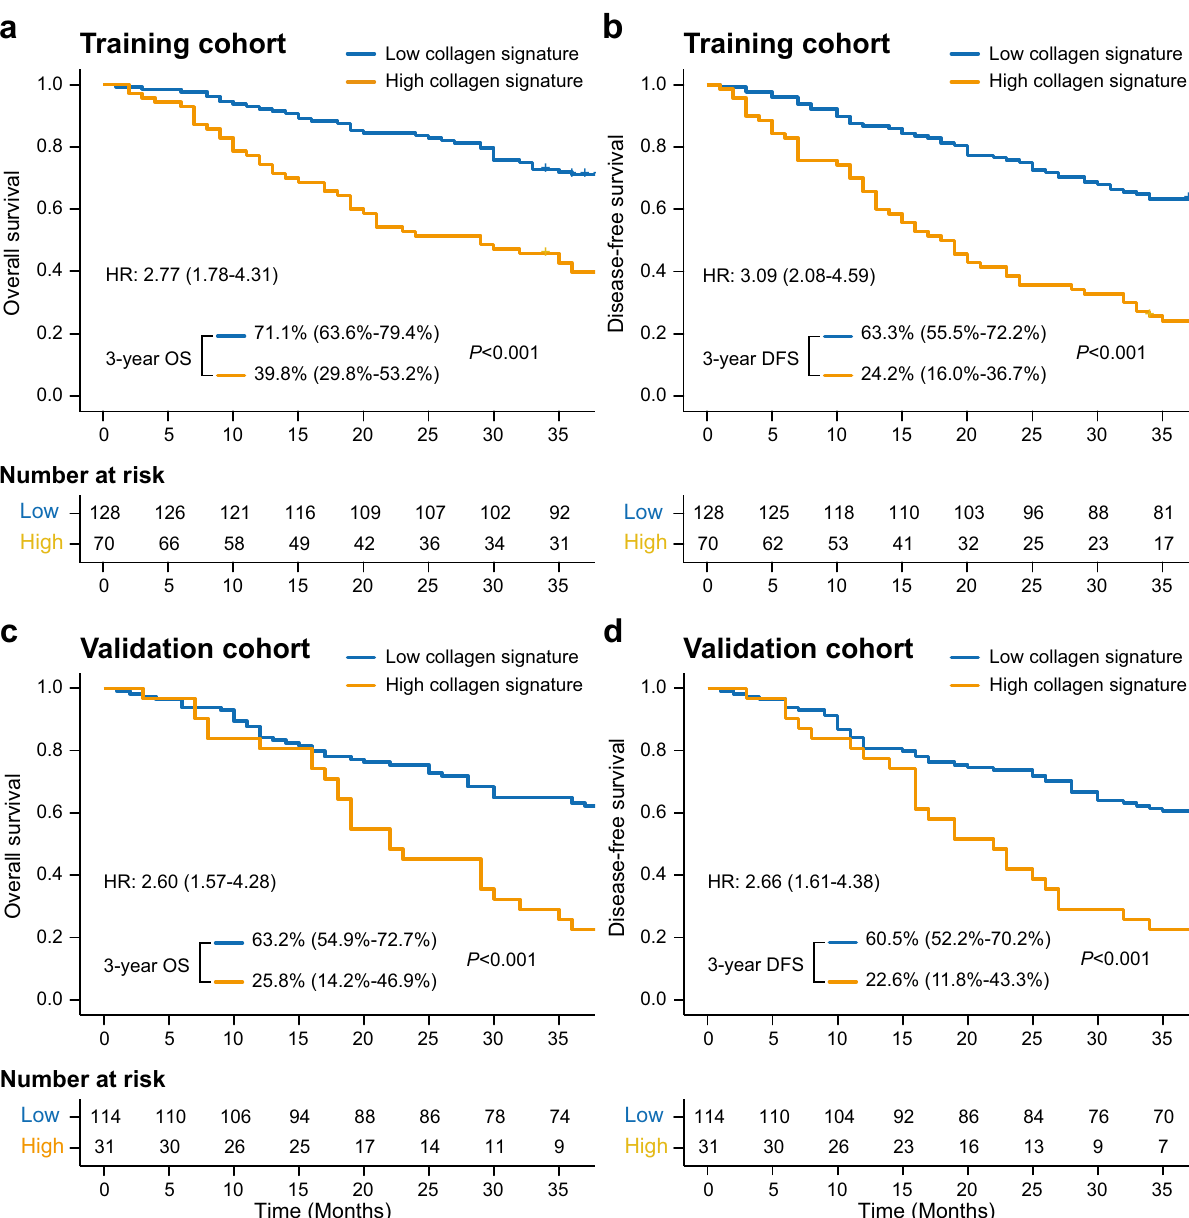
the collagen signature and built a clinicopathological model based on tumour size, tumour differentiation status and lymph node metastasis (Supplementary Table 4). The clin- icopathological model yielded average C-indexes of 0.757 (95% CI: 0.748 – 0.765) and 0.676 (95% CI: 0.662 – 0.697) in the training and validation cohorts, respectively, and the nomo- gram based on the collagen signature presented a more robust ability to predict peritoneal metastasis in all enroled patients [C-index comparison: 0.779 (95% CI: 0.773 – 0.786) vs. 0.736 for the training and validation cohorts, respectively]